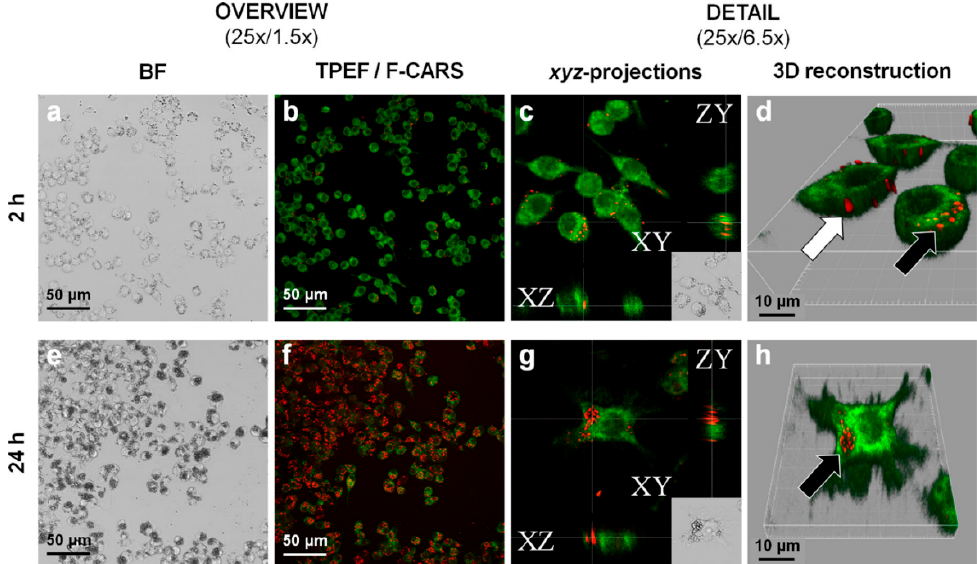
Figure 5. Paliperidonepalmitate nano-/microcrystal–cell interactions with RAW 264.7 macrophages imaged by CARS. Incubation time 2 h ( a – d ) and 24 h ( e – h ) with 250 µg/mL of paliperidonepalmitate nano-/microcrystals. a and e : low and high magnification bright field imaging. b and f : FCARS ( red )/TPEF ( green ) merged micrographs of stained/fixed RAW 264.7 macrophages. c and g : orthogonal projections of z-stacked F-CARS/TPEF overlays showing intracellular nano-/microcrystals. d and h : three-dimensional reconstructions of the z-stacked F-CARS/TPEF overlays. The white arrow shows solid paliperidonepalmitate nanocrystals adsorbed onto the cell surface and black arrows phagocytosed nanocrystals (reprinted from [74] with permission. Copyright Elsevier 2015).